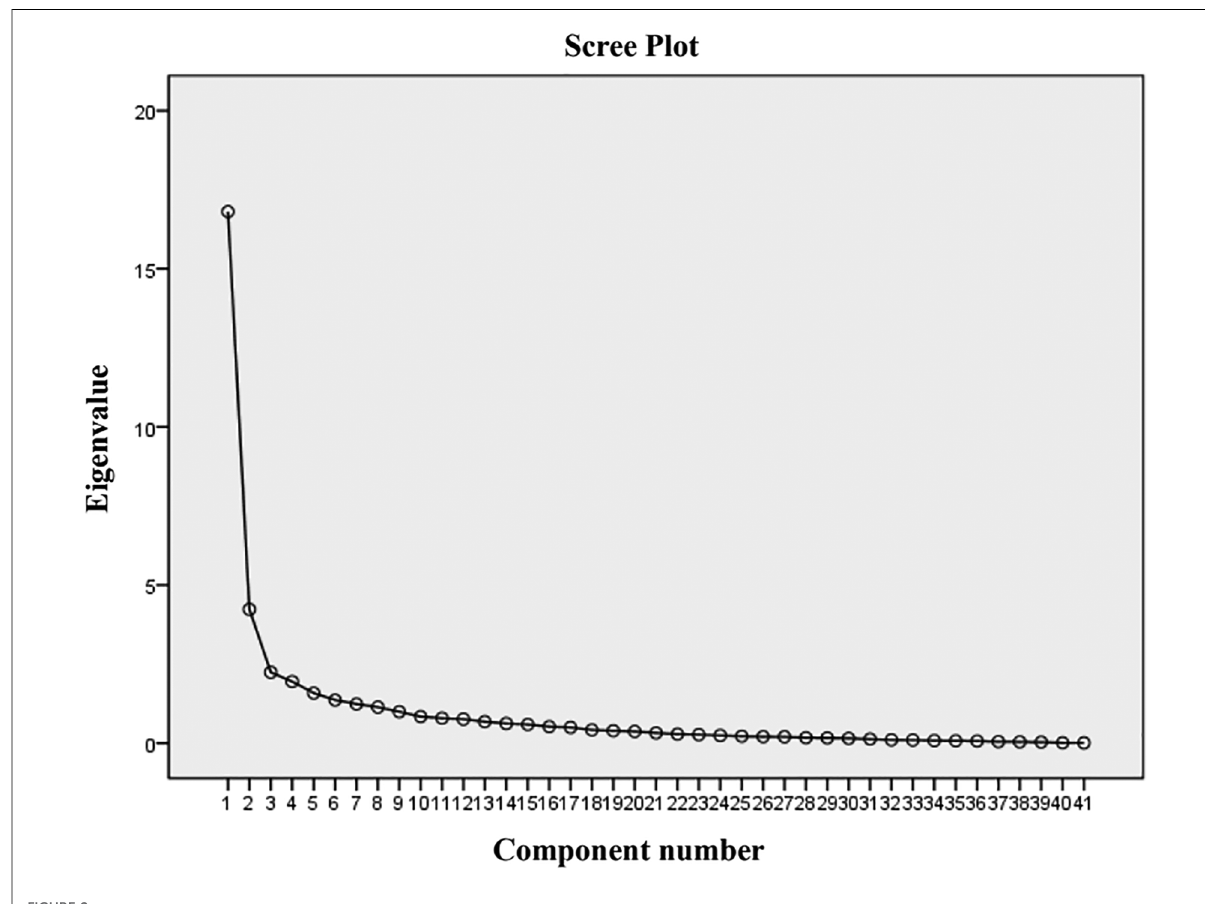
FIGURE 2 Scree plot of the 41-item PedsQL ™ stem cell transplant scale. There were eight factors with an eigenvalue greater than